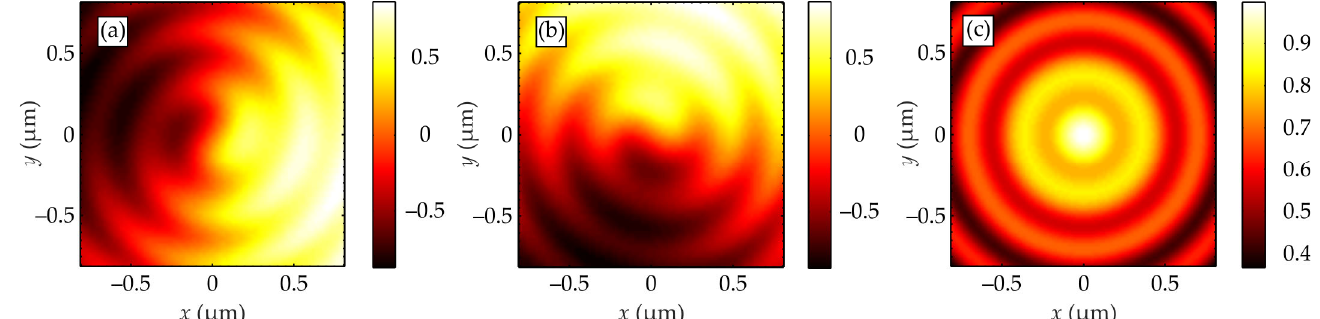
Figure 8. Distribution of the three components of the normalized Stokes vector S 1 ( a ), S 2 ( b ), S 3 ( c ) in a plane located at a distance z = λ from the focus when light is focused by an aplanatic lens with NA = 0.95.